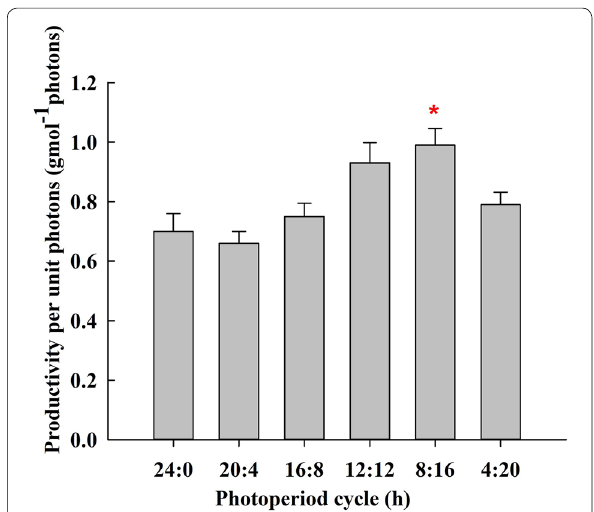
Fig. 7 Effect of illumination cycle on utilisation of unit photons of B. braunii SAG807‑1 under attached cultivation. Data are means ard deviations of three